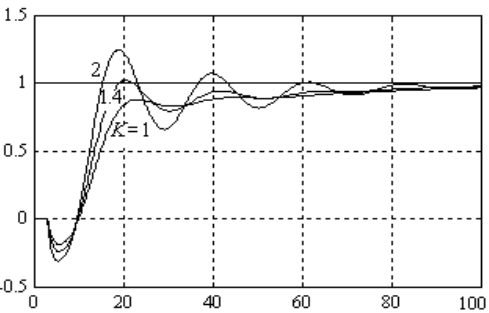
Figure 25. Responses y ( t ) to a unit step reference for K = 1; 1.4; 2.